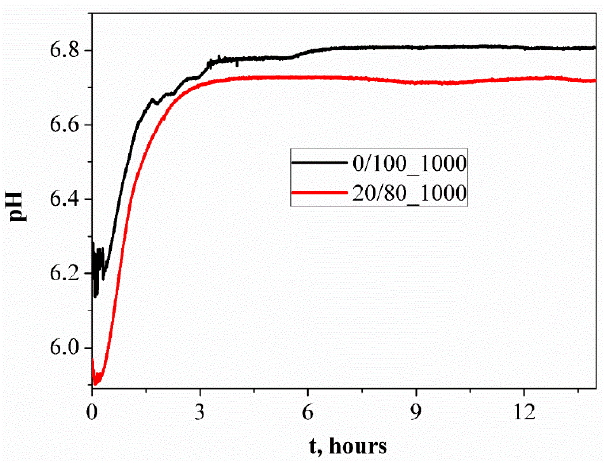
Figure 14. The pH metering of the aqueous solutions of ceramic samples fired at 1000 °C.